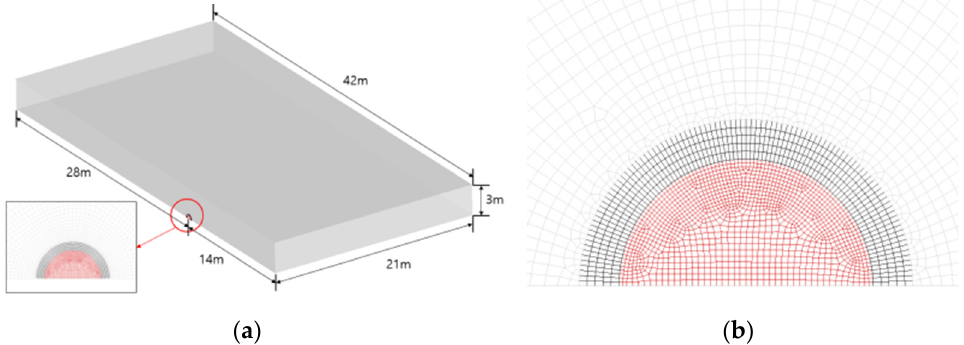
Figure 13. Explosion simulation model in underground parking lot: ( a ) schematic; ( b ) mesh gener- ation.